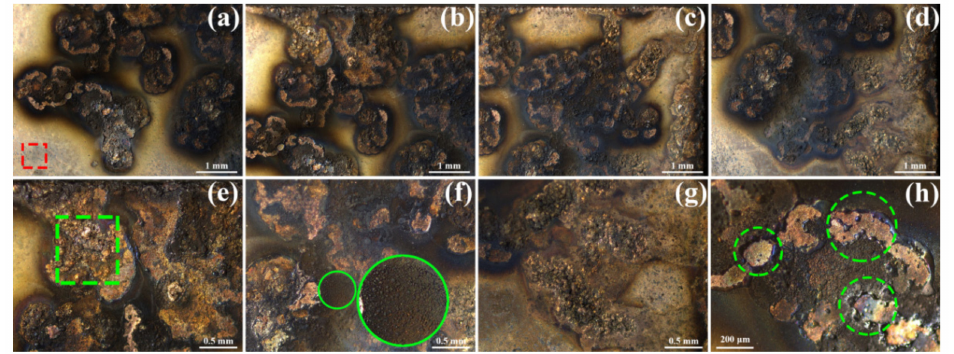
Figure 4. 3D LSCM images of ( a )–( d ) whole eroded Cu-Ti 3 AlC 2 surface; ( e ) and ( g ) morphologies caused by forces; ( f ) sputtered particles; ( h ) magnified morphology in ( b